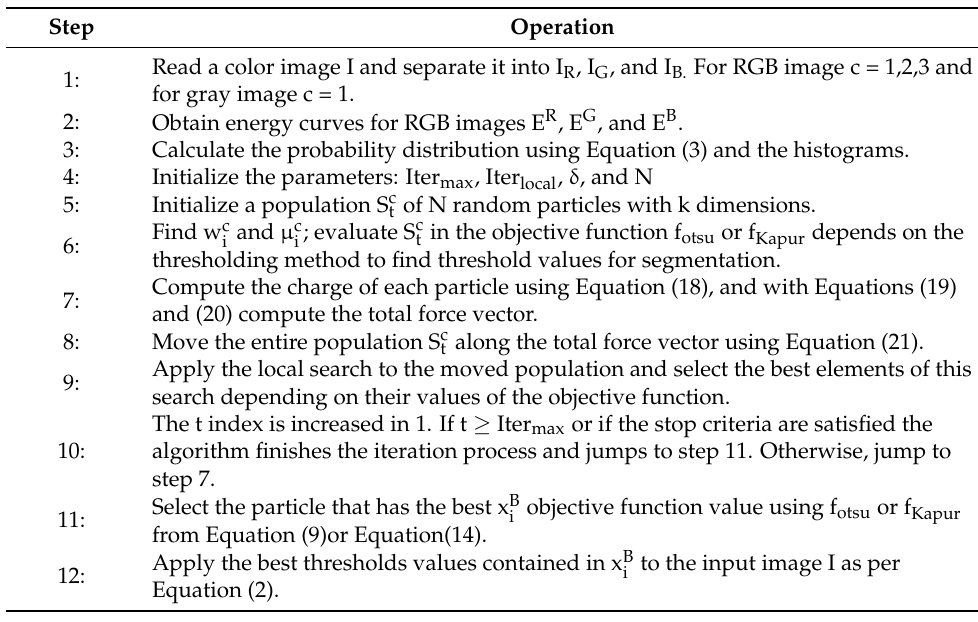
Table 18. Steps for implementation of the Proposed method on a color